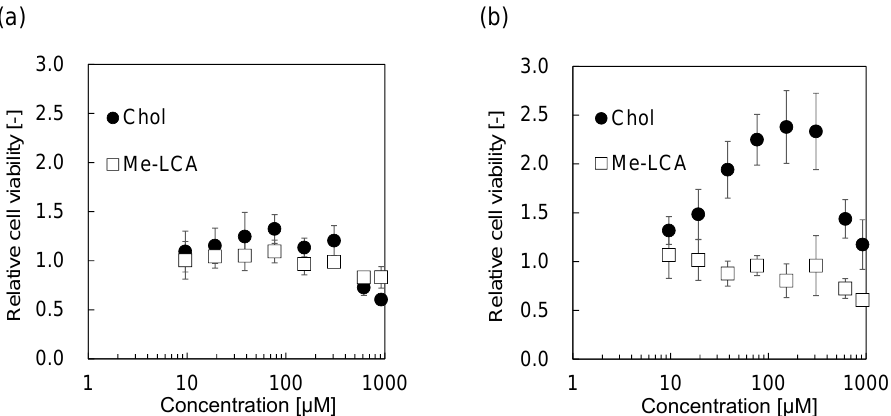
Figure 7. Cell viability of ( a ) Hep G2 and ( b ) HeLa cells treated with Chol or Me-LCA.